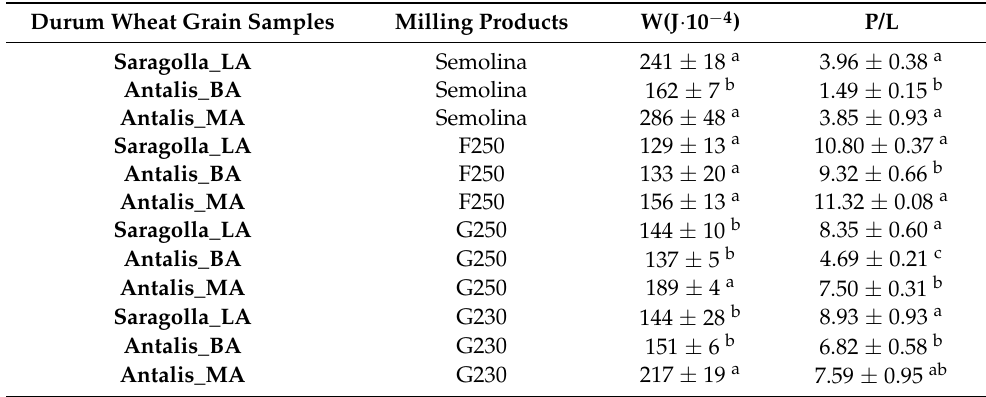
Table 2. Alveographic parameters of semolina and F250, G250 and G230 air-classified fractions obtained from three durum grain samples (Saragolla_LA, Antalis_BA, Antalis_MA). Different letters indicate significant differences ( p < 0.05) within each milling products; n = 5.